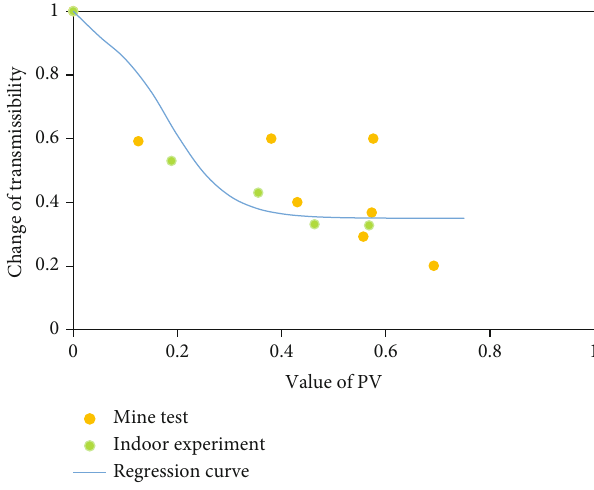
Figure 13: Relation curve of plugging agent injection volume and formation percolation ability.